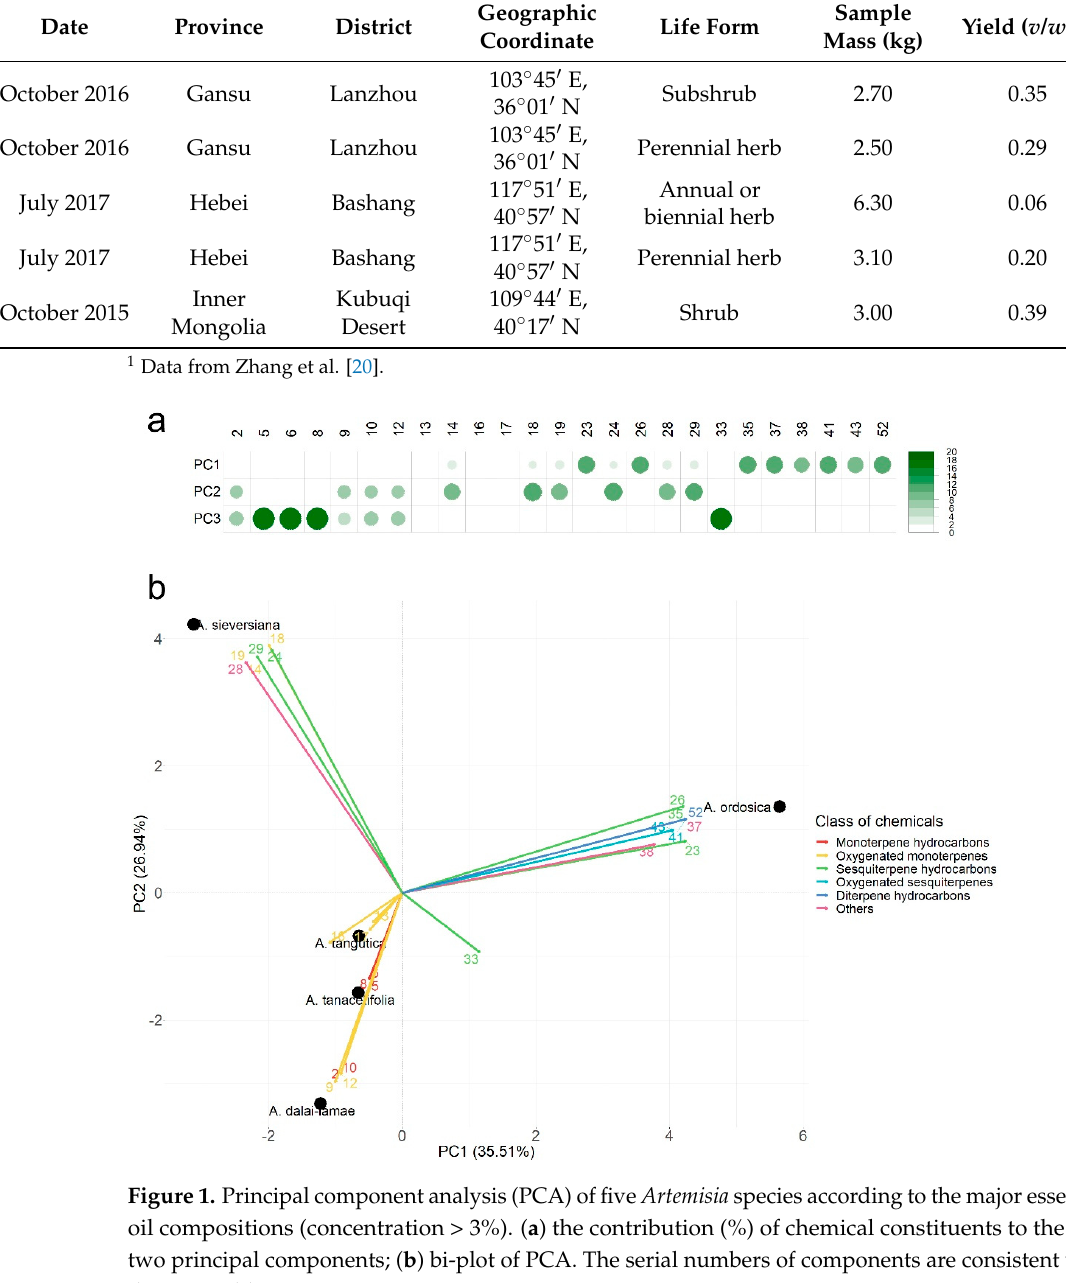
Figure 2. Dendrogram analysis based on essential oil components of five Artemisia species.